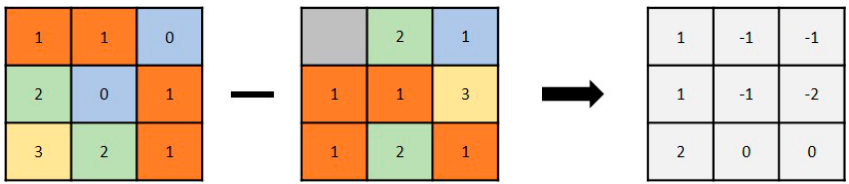
Figure 7. Example of the arithmetic operation used for two raster images to generate the post ‐ earthquake damage map of Palu, Indonesia.